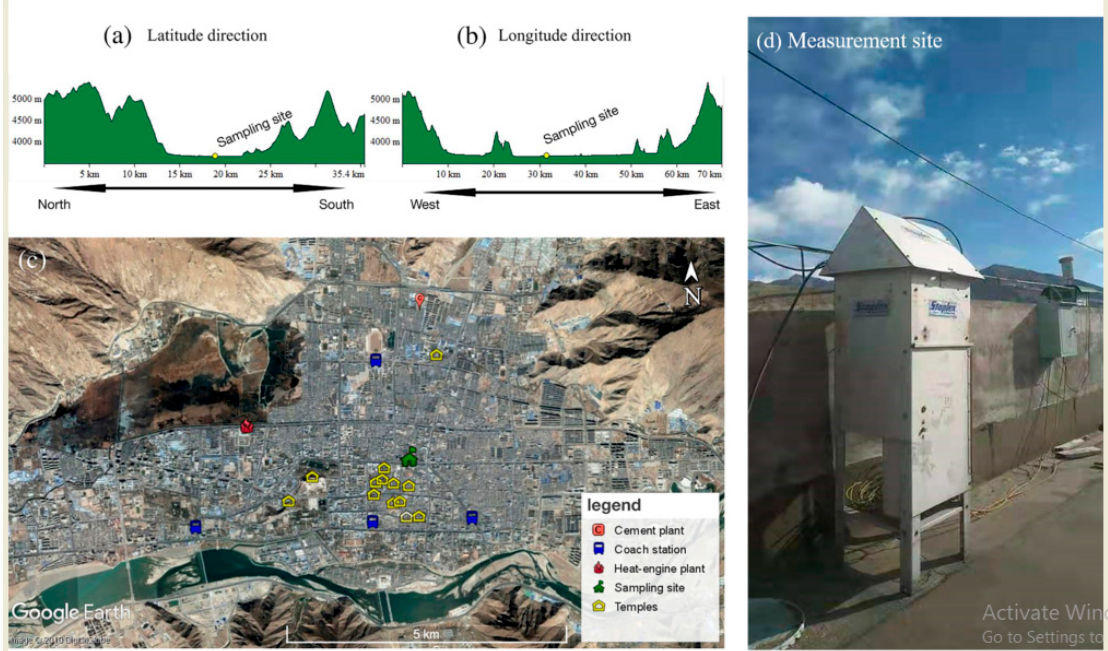
Figure 1. ( a ) Topographic distribution in the latitude direction. ( b ) Topographic distribution in the longitude direction. ( c ) Locations of the sampling sites and typical emission sources on the Google Earth map. ( d ) The photo of the measurement site.